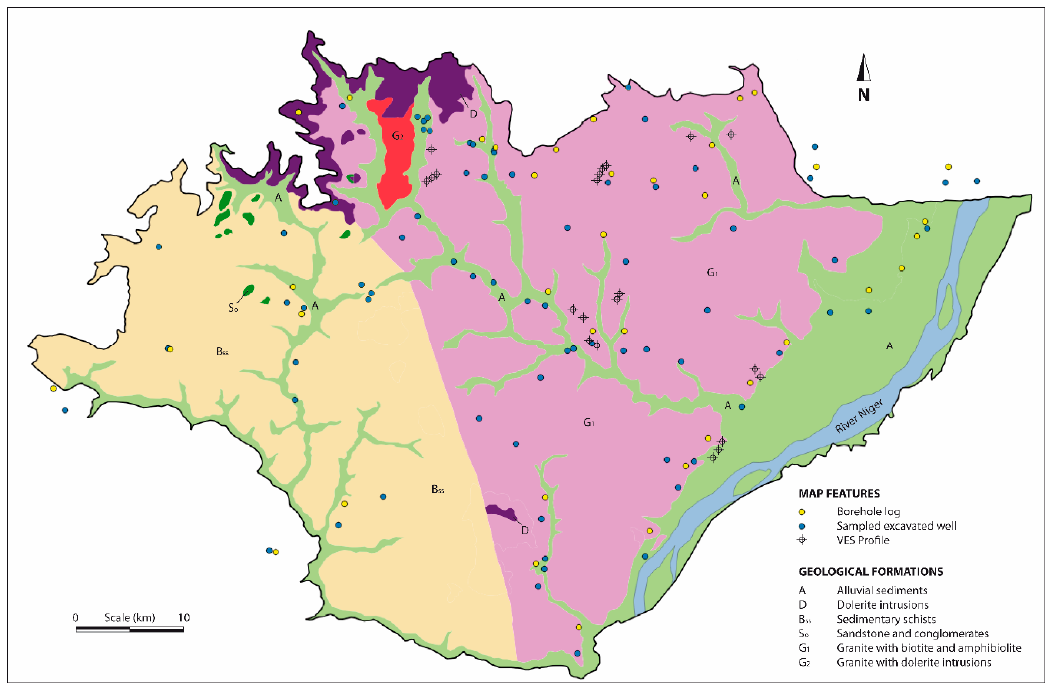
Figure 3. Geological map of the study area, including the presence of borehole logs, sampled wells, and vertical electrical sounding profiles.